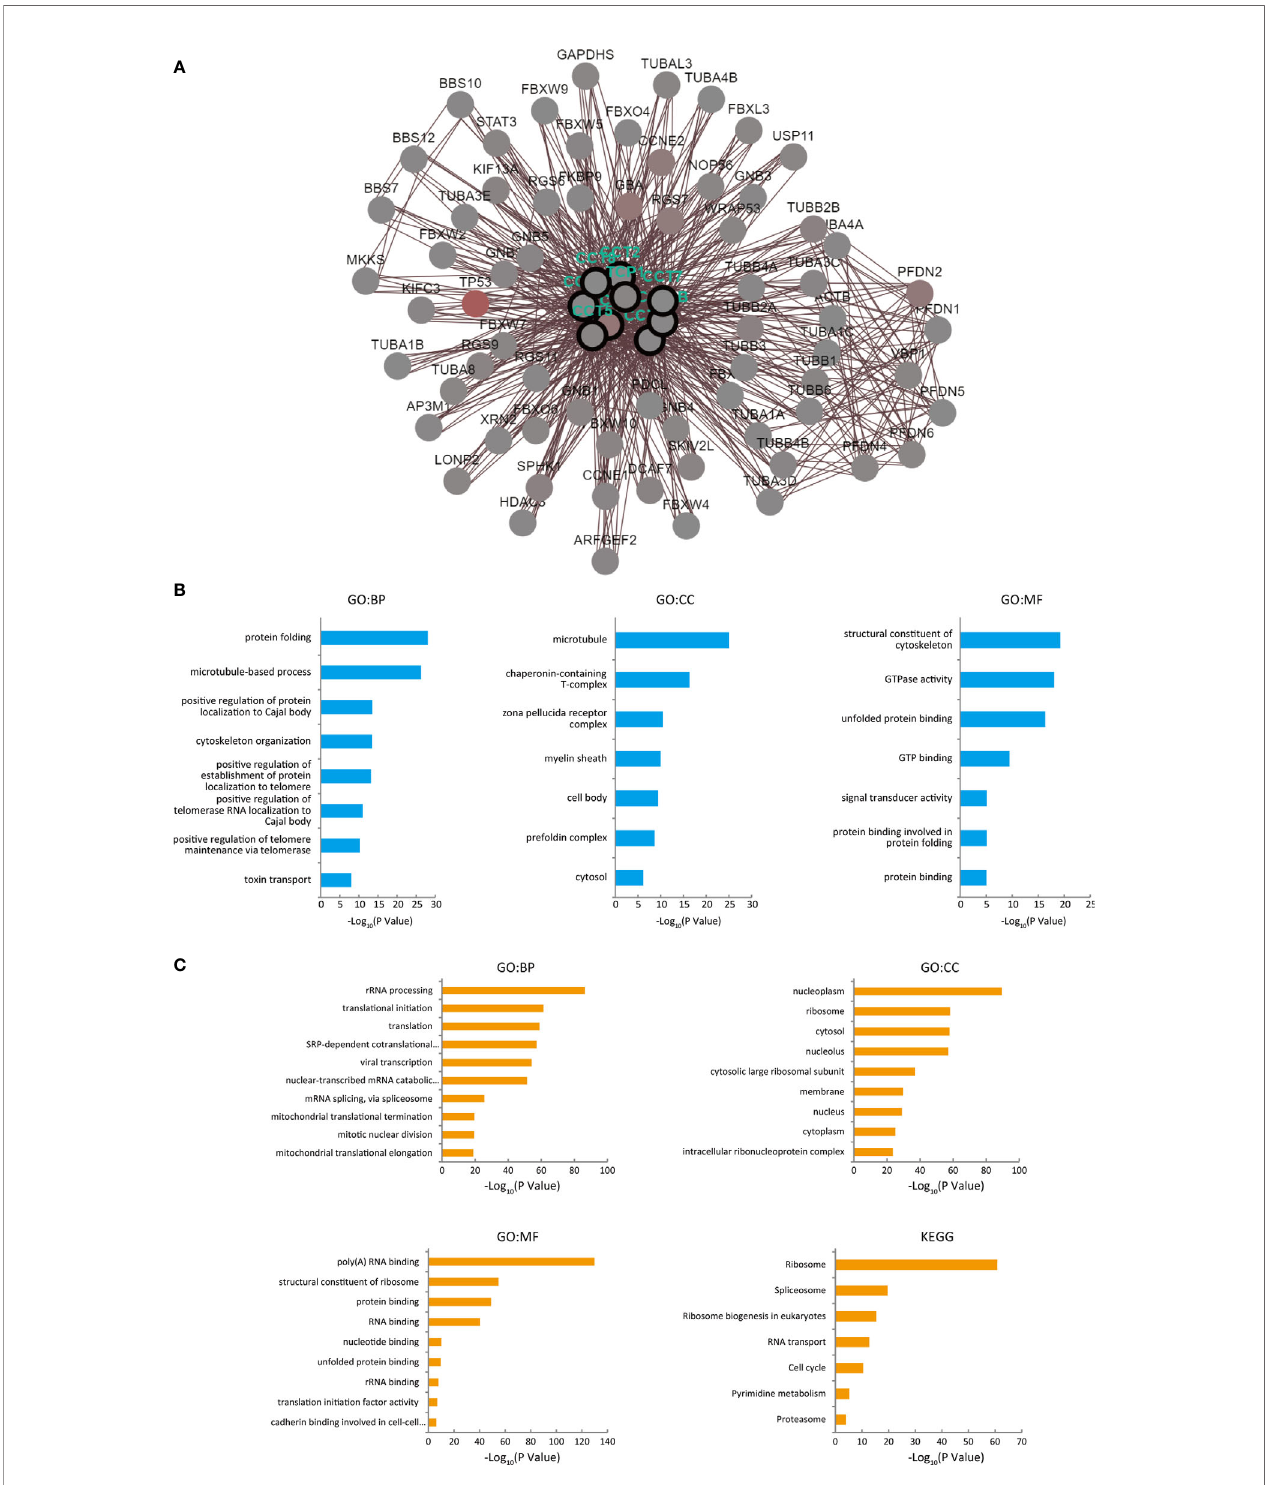
FIGURE 6 | Functional enrichment analyses of TRiC subunit genes, their neighbor genes and their co-expressed genes in HCC patients (from cBioPortal and DAVID). (A) Biological interaction network of CCT genes and their neighbor genes which were associated with CCT mutations. (B) GO enrichment analysis showing biological processes, cellular components, and molecular functions of CCT subunit and neighboring network genes. (C) GO functional annotation and KEGG pathway enrichment analysis of CCT subunit proteins and co-expressed genes were conducted proteins using